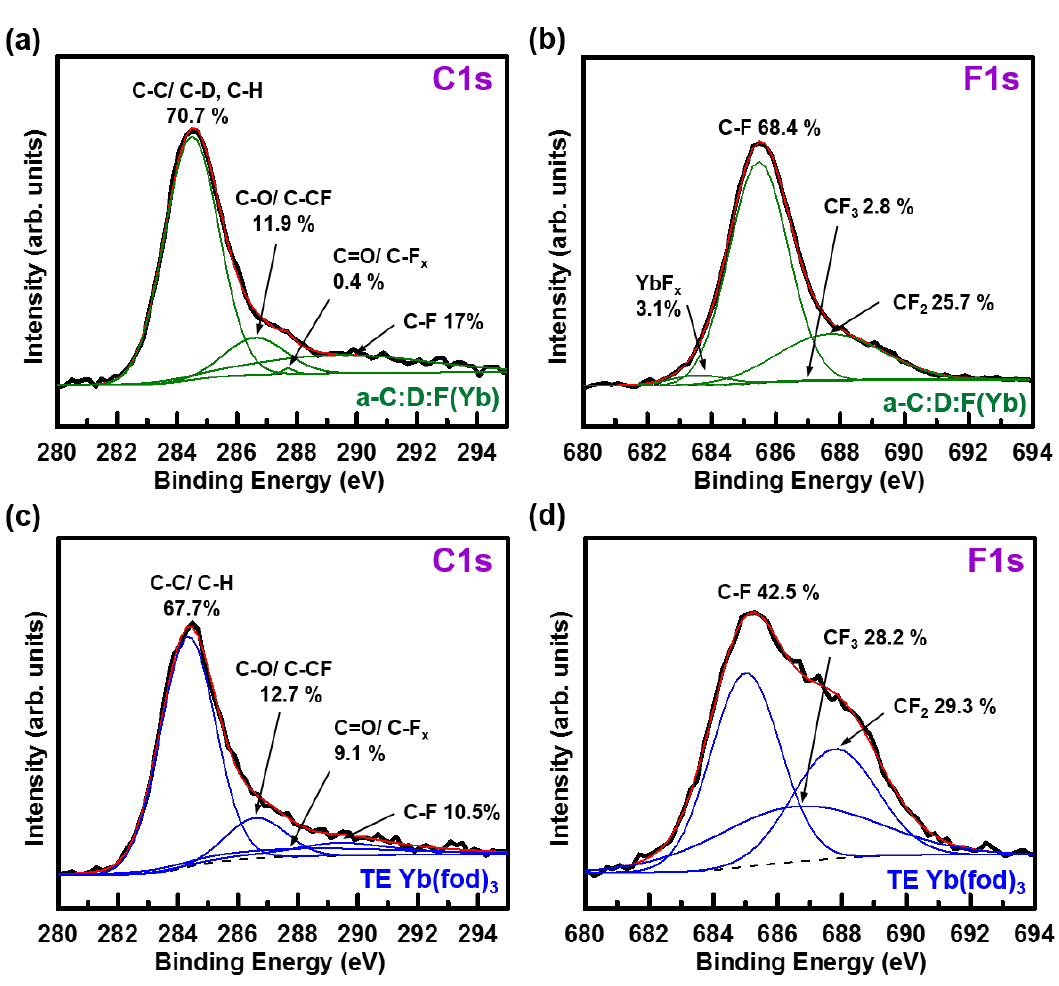
Figure 5. Deconvoluted XPS ( a ) C1s and ( b ) F1s spectra of the a-C:D:F(Yb) film with maximum I prepared using RF power of 60 W, precursor gas flow rate of 20 sccm, nor deposition pressure of 60 mTorr, substrate temperature of 80 °C, and Yb(fod) evaporated at a temperature of 110 °C; and ( c ) C1s and ( d ) F1s spectra of the TE Yb(fod) 3